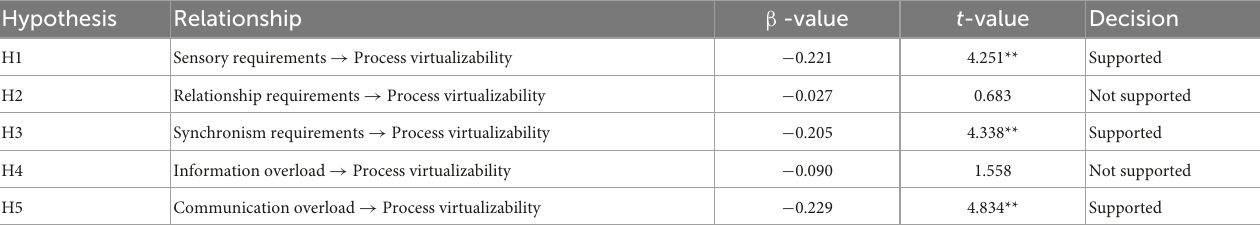
TABLE 6 Path coefficients and hypothesis